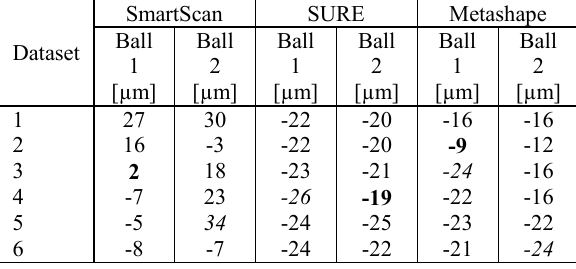
Table 3. Quality parameter probing error PS